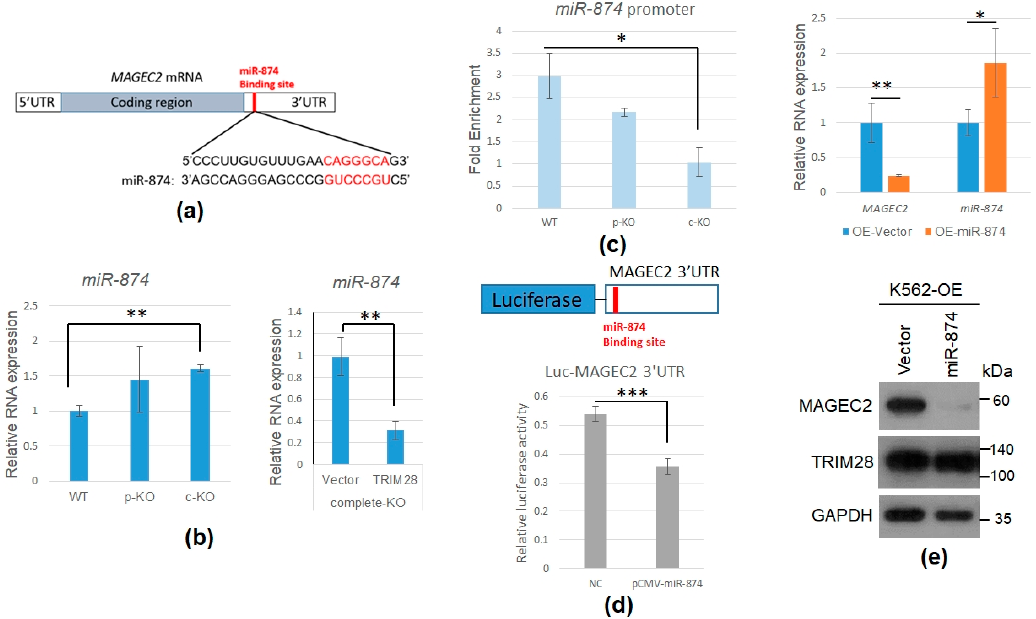
Figure 6. TRIM28 KO induces miR-874 to downregulate MAGEC2 expression. ( a ) MAGEC2 mRNA 3 ′ UTR contains a miR-874 targeted element. ( b ) miR-874 was induced in TRIM28 complete-KO K562 cells ( left panel). Overexpression of Trim28 in complete-KO K562 cells decreased miR-874 expression using qPCR analysis ( right panel). ( c ) ChIP assay. The WT, partial-KO (p-KO), and complete-KO (c-KO) cells were fixed by formaldehyde and IPed with anti-TRIM28. The precipitated genomic DNA was qPCR analyzed with miR-874 promoter primers. ( d ) Ectopic expression of miR-874 downregulates MAGEC2 3 ′ UTR-containing luciferase reporter in HEK293T cells. ( e ) The WT K562 cells were overexpressed (OE) with a cloning vector or miR-874 expression plasmid. After drug selection, RNAs were isolated for qPCR analyses with MAGEC2 or miR-874 primers ( upper panel), and whole-cell extracts were Western blotted with indicated antibodies ( lower panel). * p < 0.05, ** p < 0.01, and *** p < 0.001.